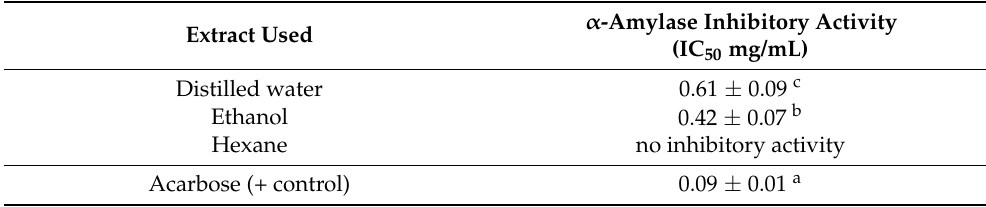
Table 2. In vitro α -amylase inhibitory activity of C. nervosum extracts. Extract Used